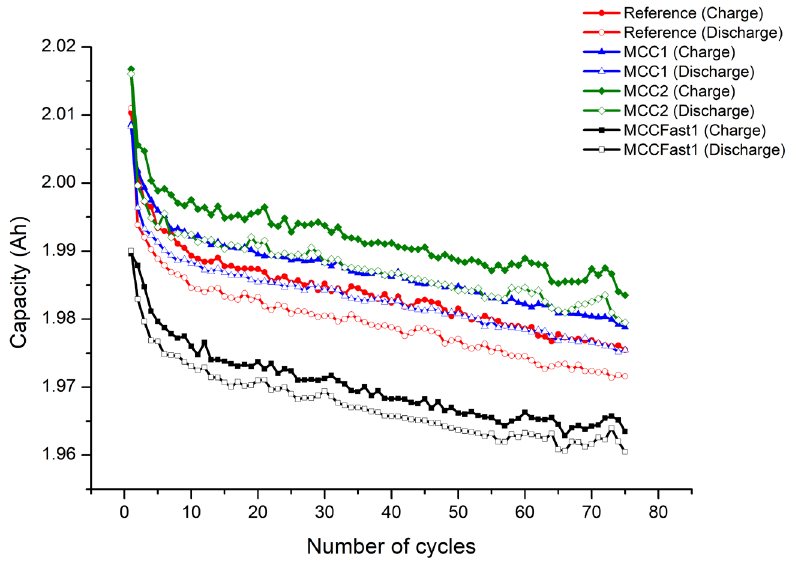
Figure 12. Charged–Discharged capacity as a function of the cycle number during the first cycle aging step (75 cycles).